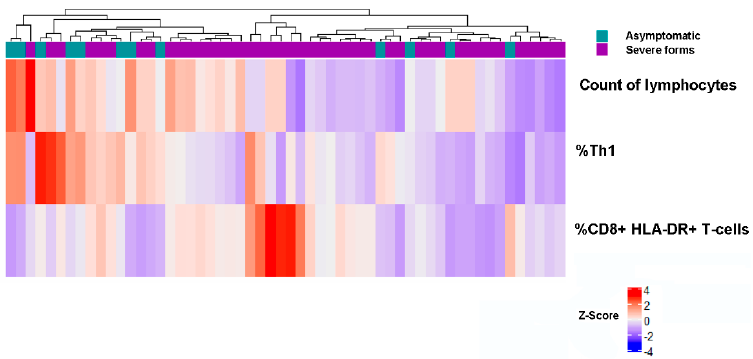
Figure 8. Heatmap and hierarchical clustering analysis of asymptomatic COVID-19 patients vs. COVID-19 patients with severe forms of the disease. Two different groups are represented, asymp- tomatic patients with higher total number of lymphocytes and robust Th1 immunity and those patients with severe forms of the disease with a higher proportion of activated CD8+ T cells.